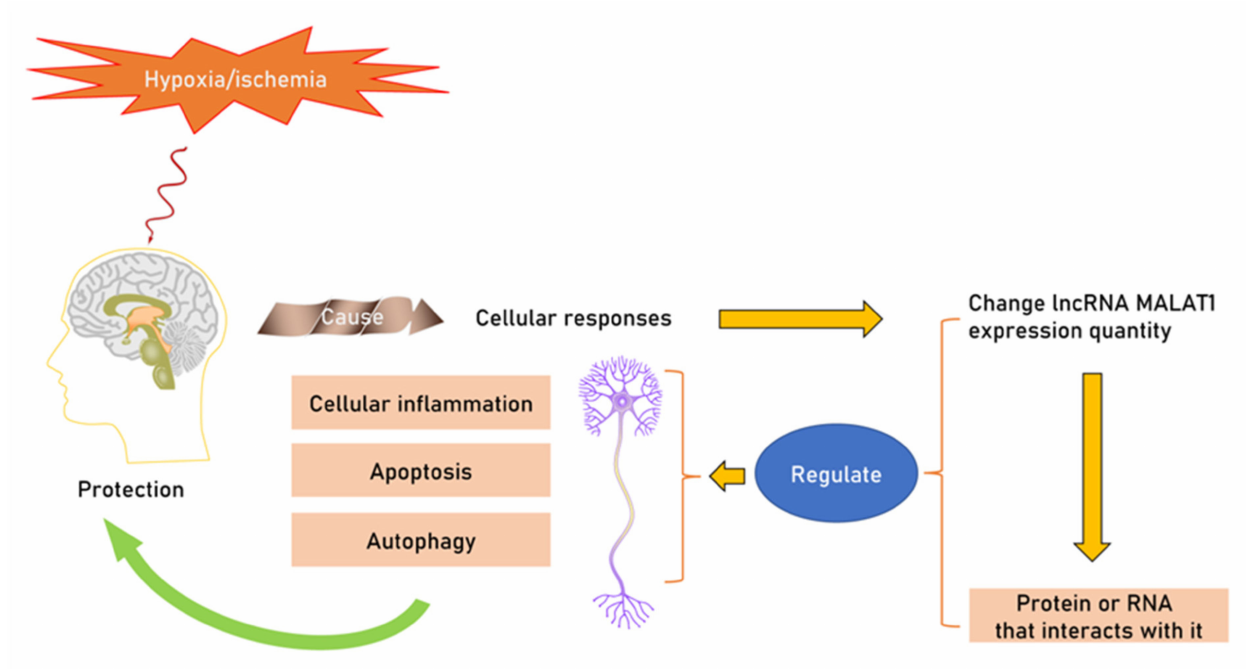
Figure 1. The neuroprotective function of MALAT1 under hypoxic/ischemic conditions. MALAT1 functions as a regulator during the transcriptional and post-transcriptional process through inter- action with proteins or RNAs. In addition, neuroprotective mechanisms including inflammation, apoptosis and autophagy are